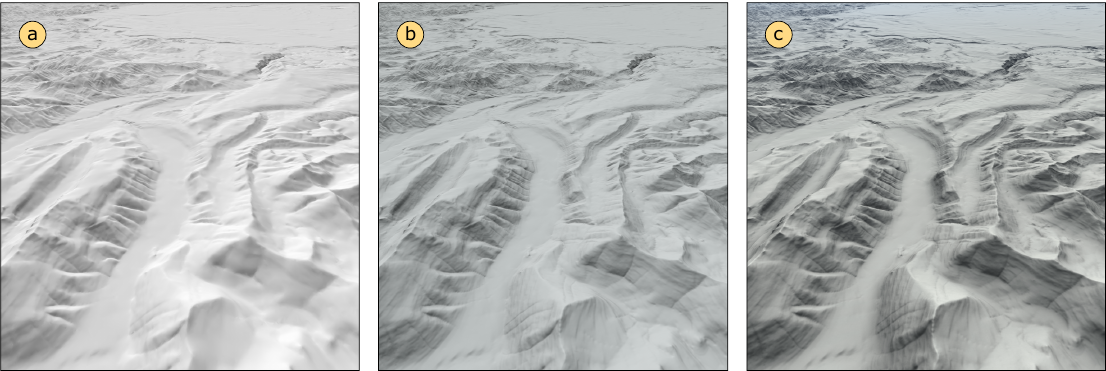
Figure 3. Conveying fine 3D structures of the terrain surface using different illumination models: ( a ) local illumination; ( b ) local illumination combined with ambient occlusion; and ( c ) global